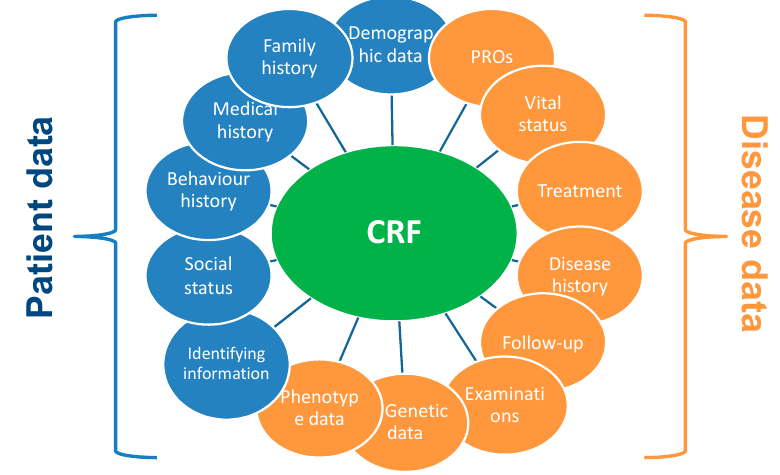
Figure 2. Examples of Case Report Form module.